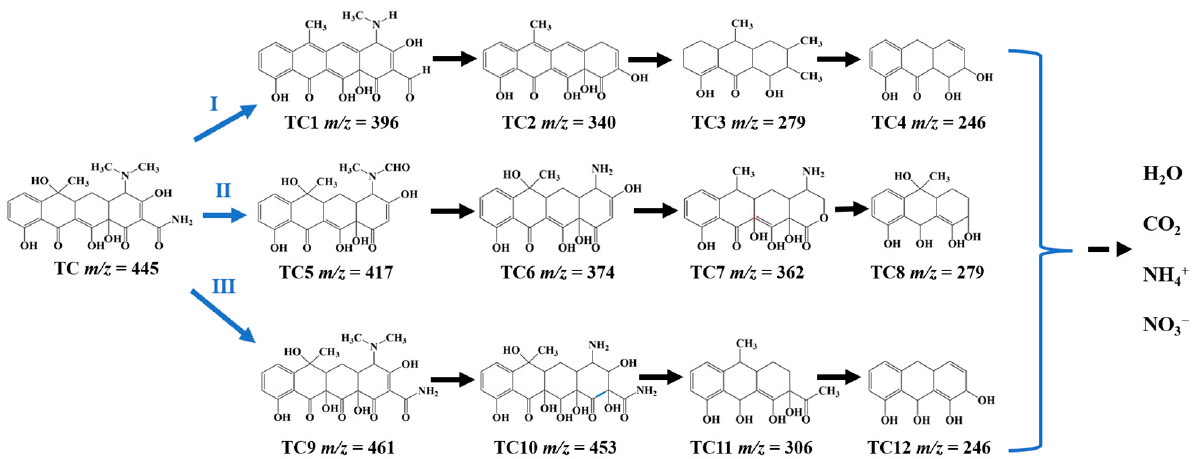
Figure 9. Intermediates and the possible photocatalytic degradation pathways for TC removal using TB-3.